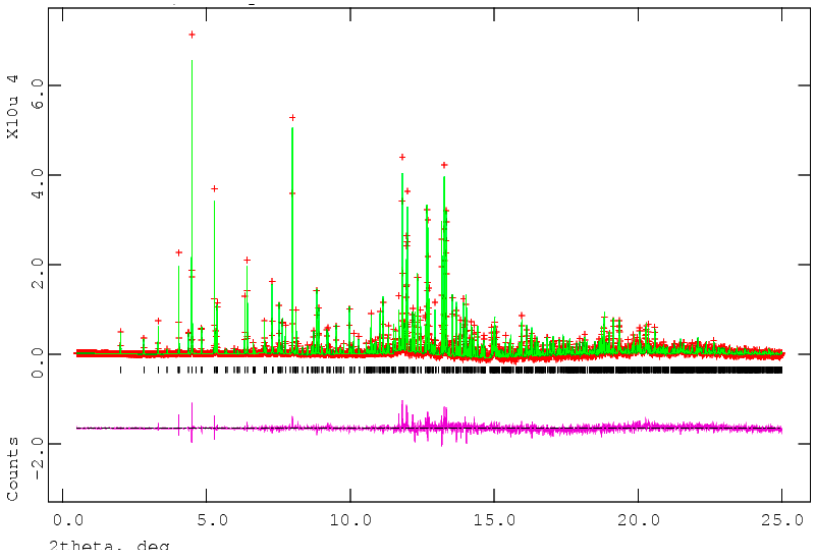
Figure 5. The Rietveld plot for the refinement of 17 α -dihydroequilin, using the correct molecular formula C 18 H 22 O 2 . The red crosses represent the observed data points, and the green line is the calculated pattern. The magenta curve is the difference pattern, plotted at the same vertical scale as the other patterns. The vertical scale has been multiplied by a factor of 5 for 2 θ > 6.80°, and by a factor of 40 for 2 θ > 11.5°. X-ray wavelength of 0.413342 Å.